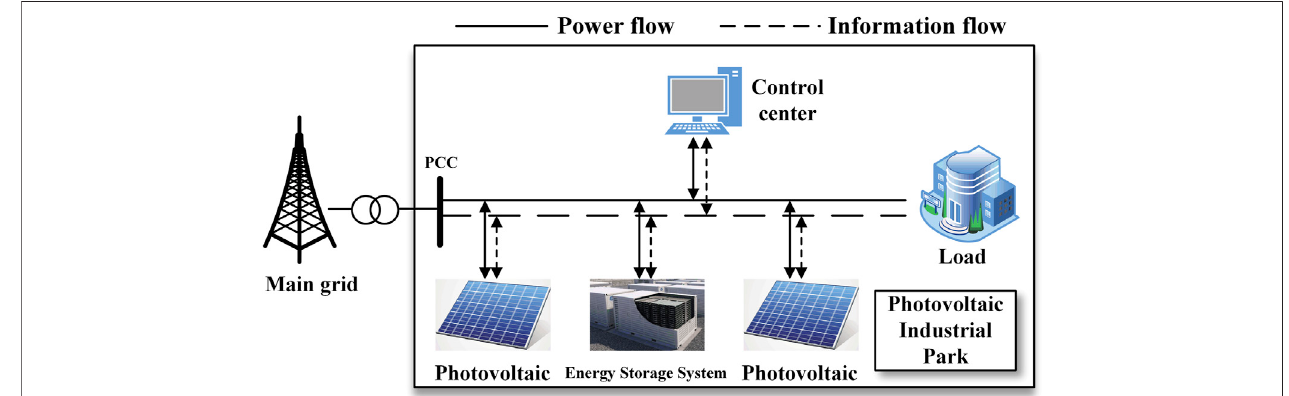
FIGURE 1 | Structure diagram of PV industrial park